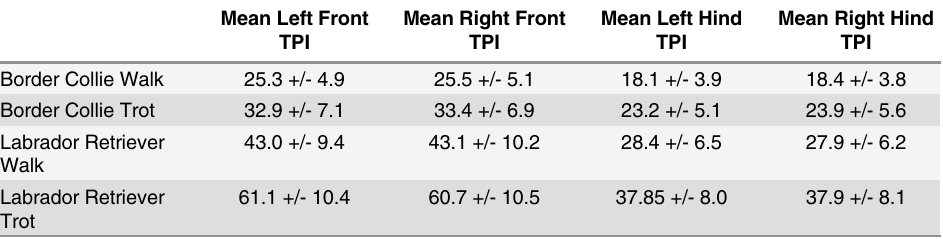
Table 1. Mean Total Pressure Index Percentage (TPI%) at the Walk and Trot for Border Collies and Labrador